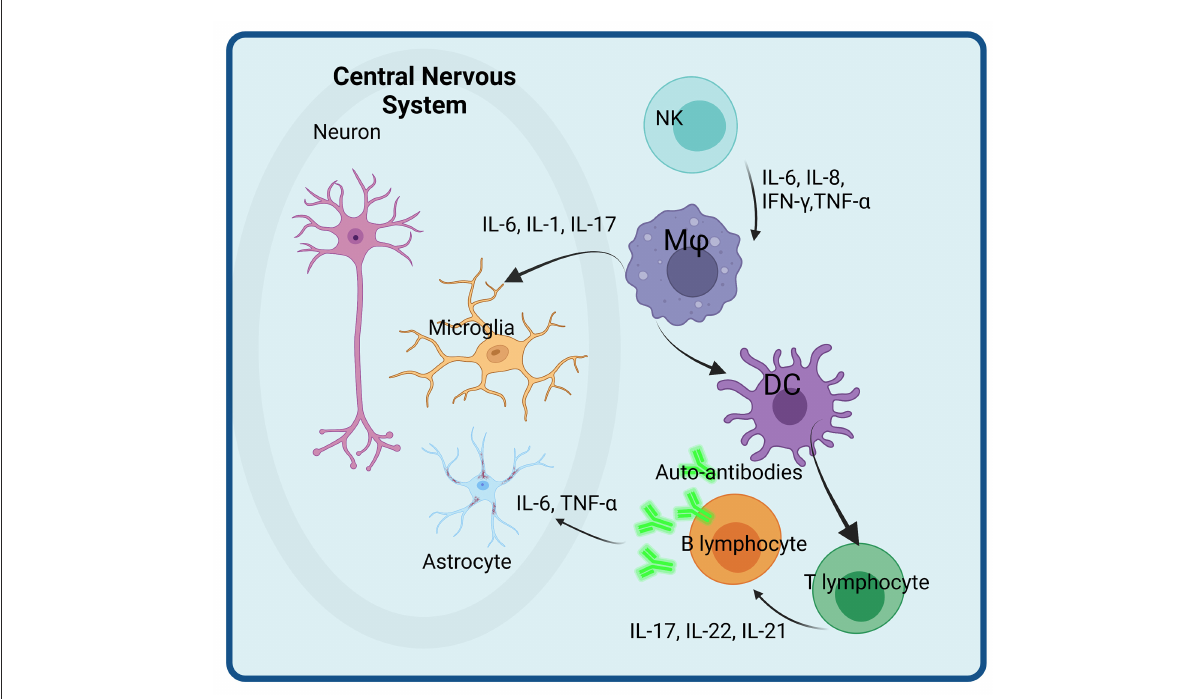
FIGURE1 Immune cells and their secreted immune-related molecules with potential roles in neuro-inflammation in ASD. Activated NK cells secrete pro-inflammatory cytokines (IL-6, IL-8, IFN, and TNF) that activate macrophages (M ϕ ) with enhanced secretion of IL-6, IL-1, and IL-17 that impacts directly the microglial populations. Activated dendritic cells (DC) play a role in T and B lymphocytes activation, that enhance the pro-inflammatory cytokine secretion as well as the differentiation of B cells in plasma cells. The auto-antibodies thus produced further attack astrocytes. Created with